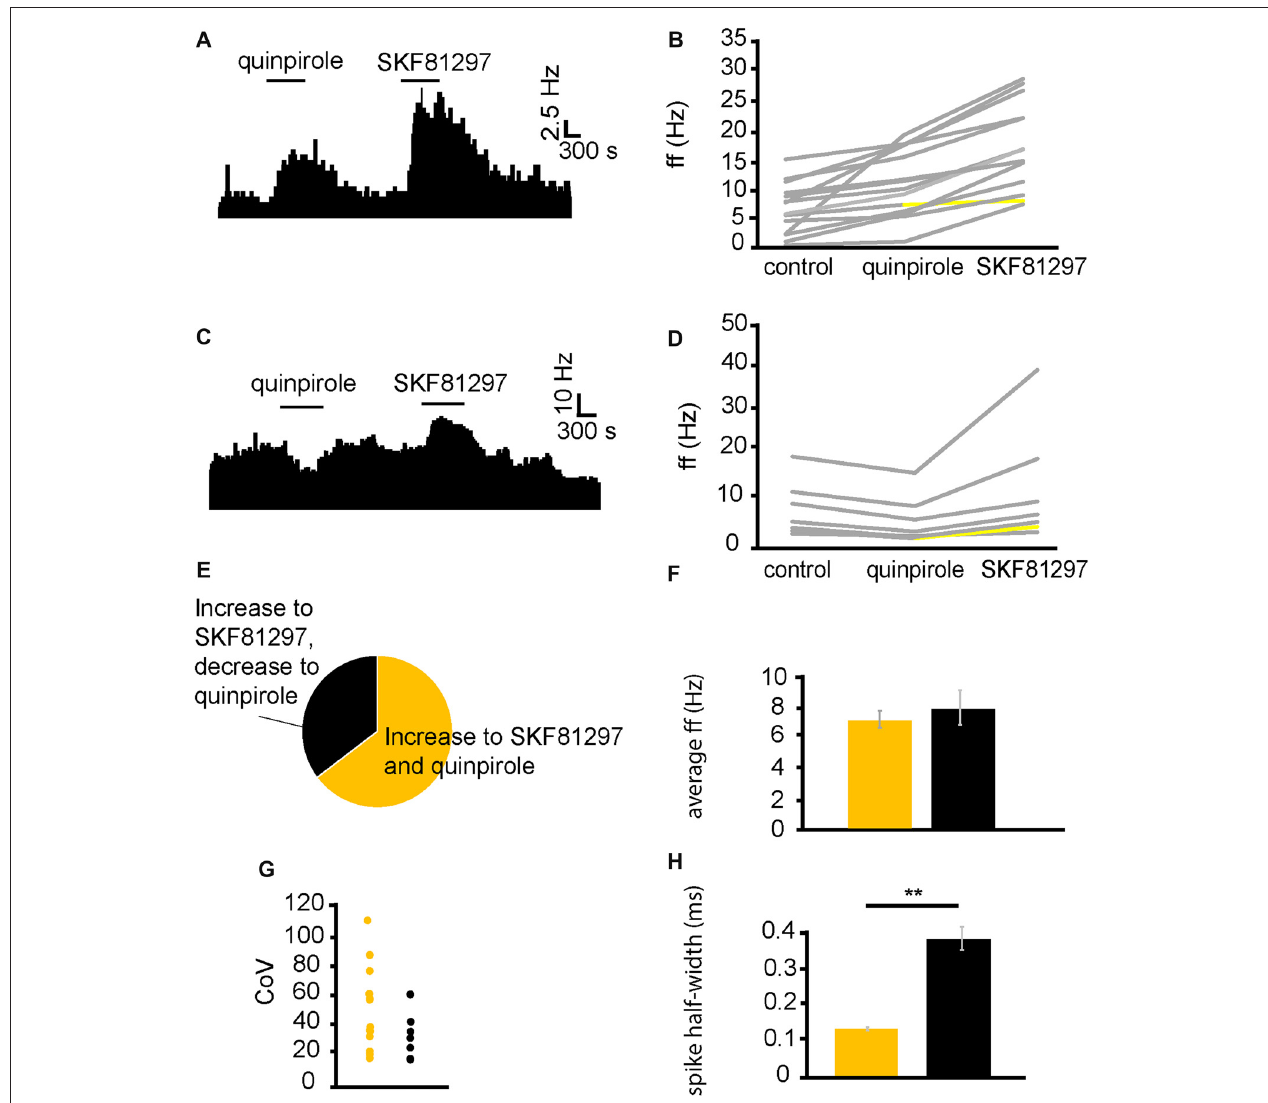
FIGURE 3 | D1-like receptor agonists excite while D2-like receptor agonists excite and inhibit VP neurons. (A) Excitatory response to the application of quinpirole and SKF81297 (separated by complete washout out). (B) Changes in firing frequency for 14 VP neurons induced by quinpirole application and SKF81297 application similar to that illustrated in panel (A) . Firing frequency was measured; before the application of quinpirole, after the application of quinpirole and subsequently, after a period of wash out, for the application of SKF81297. Responses characterized by significant ( P < 0.05) changes in firing frequency are in gray, the other ones in yellow. (C) Inhibitory response to the application of quinpirole and excitatory response to the application of SKF81297 (separated by complete washout). (D) Changes in firing frequency for seven VP neurons induced by quinpirole application and SKF81297 application similar to that illustrated in panel (C) . Firing frequency was measured; before the application quinpirole, after the application of quinpirole and subsequently, after a period of wash out, for the application of SKF81297. Responses characterized by significant ( P < 0.05) changes in firing frequency are in gray, the other ones in yellow. (E) The majority of neurons analyzed responded with increases in firing frequency in response to both quinpirole and SKF81297 (yellow), but a minority decreased their firing frequency in response to quinpirole and increased their firing frequency in response to SKF81297 (black). (F) Firing frequency for those neurons excited by both quinpirole and SKF81297 (yellow) and those neurons that were inhibited by quinpirole (black). (G) Coefficient of variation (CoV) for those neurons excited by both quinpirole and SKF81297 (yellow) and those inhibited by quinpirole (black). (H) Significant differences in spike half-width (ms) for those neurons excited by both quinpirole and SKF81297 (yellow) and those that were inhibited by quinpirole